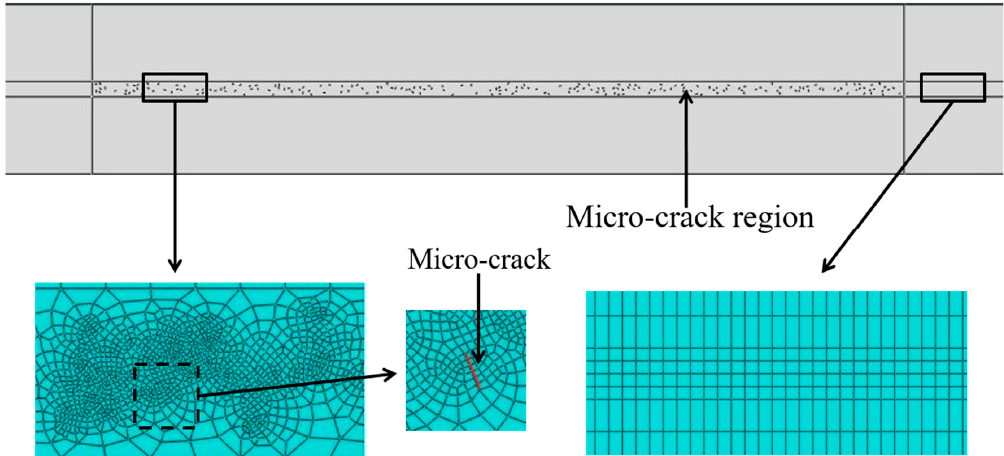
Figure 4. The FEM model of the micro-crack damage region: The distribution of micro-cracks and the finite element mesh.